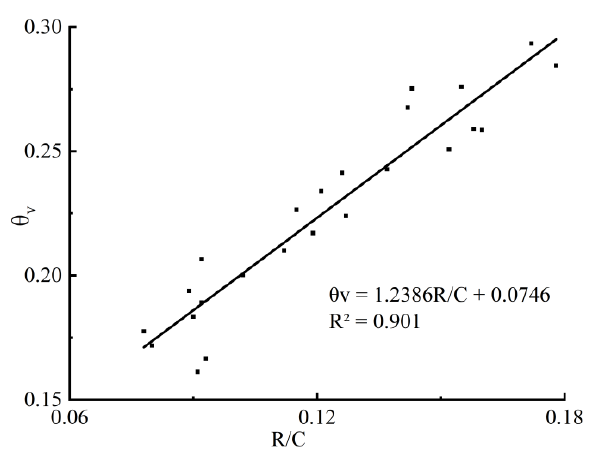
Figure 6. θ v – R/C calibration equation (B6 group). Figure 6. θ v -R/C calibration equation (B6